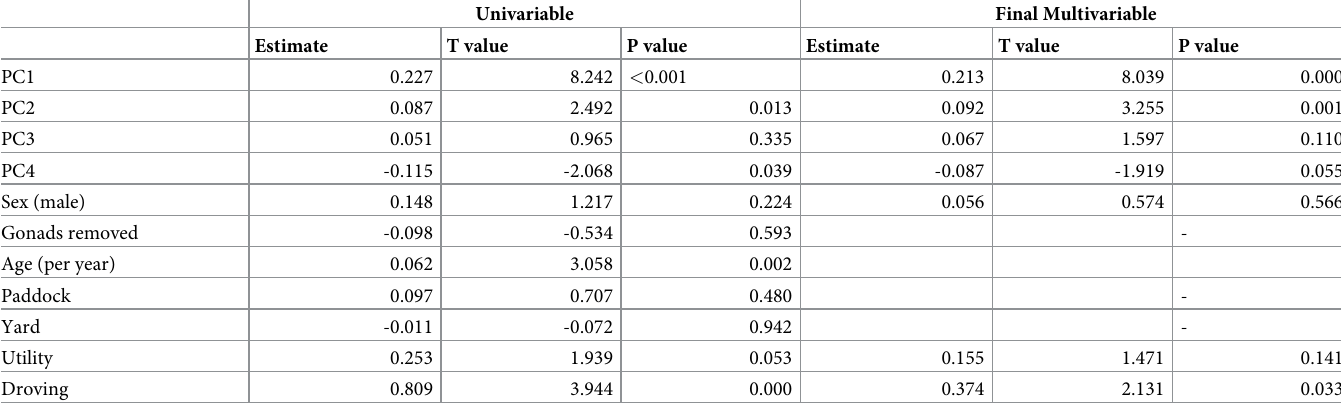
Table 5. Results of univariate and final multivariate modelling of relationships between personality traits in four clusters (PC1-PC4) and perceived overall ability in kelpies (n = 210) 12 months of age and